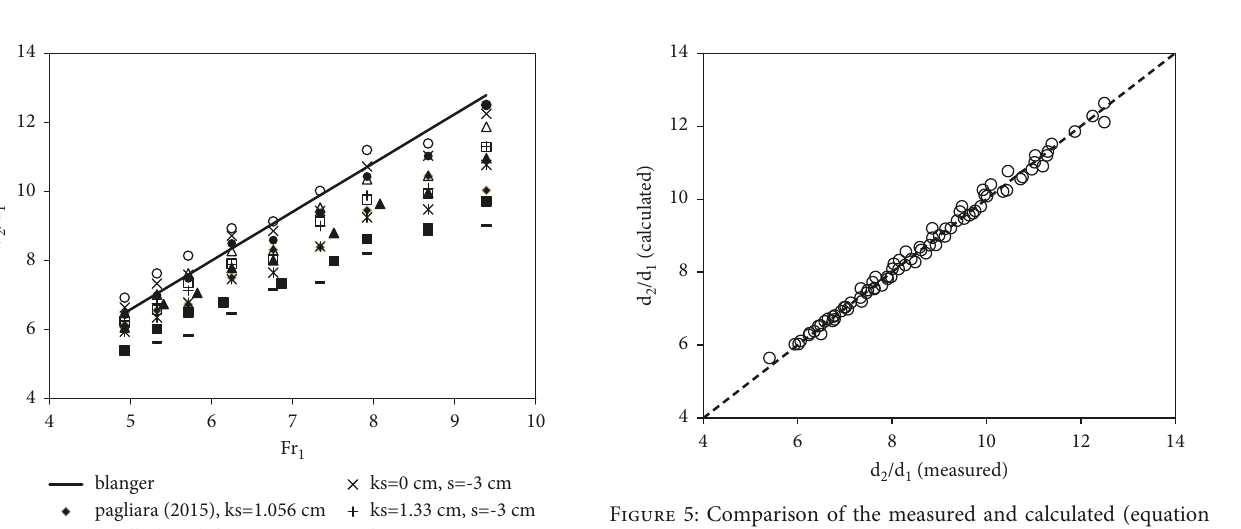
� 1.25cm and (b) k s